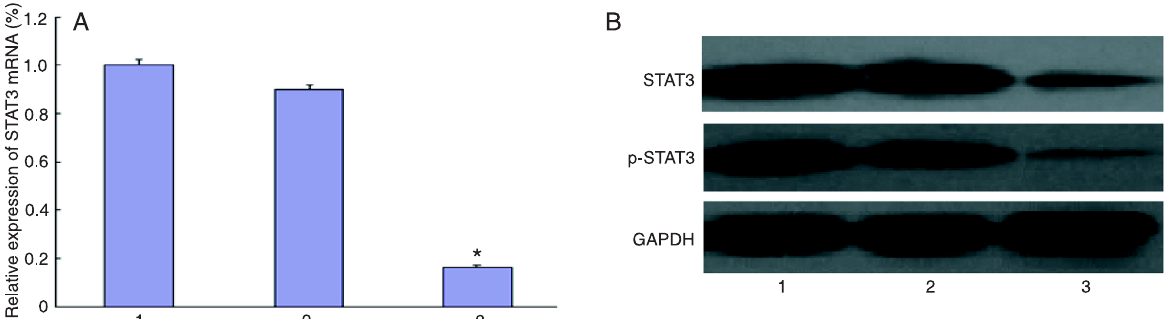
Figure 2. A , STAT3 mRNA expression in cells of each group. Group 1 , HT-29 cells; group 2 , HT-29-GFP cells; group 3 , HT-29-shSTAT3 cells. Data are reported as means ± SEM (N = 3). *P < 0.01, significantly different from the other two groups (ANOVA). B , Expression and activation of STAT3 proteins in cells of each group. Lane 1 = HT-29 cells; lane 2 = HT-29-GFP cells; lane 3 = HT-29-shSTAT3 cells.